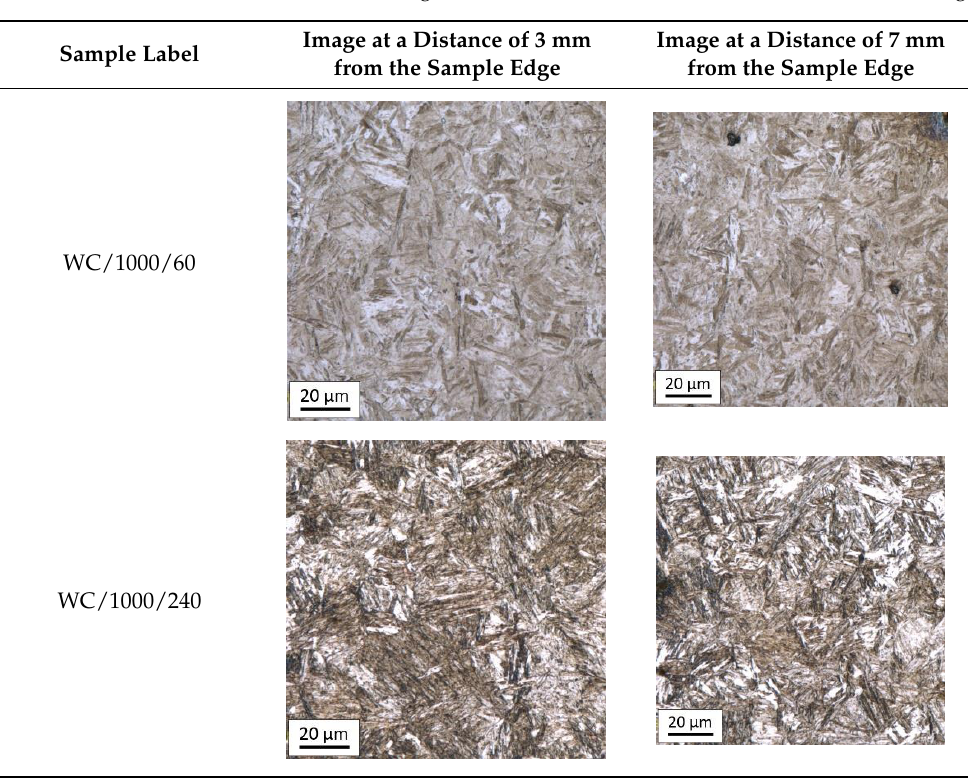
Table 9. Microstructure of steel after heating at 1000 °C for 60 min and 240 min with water-cooling.